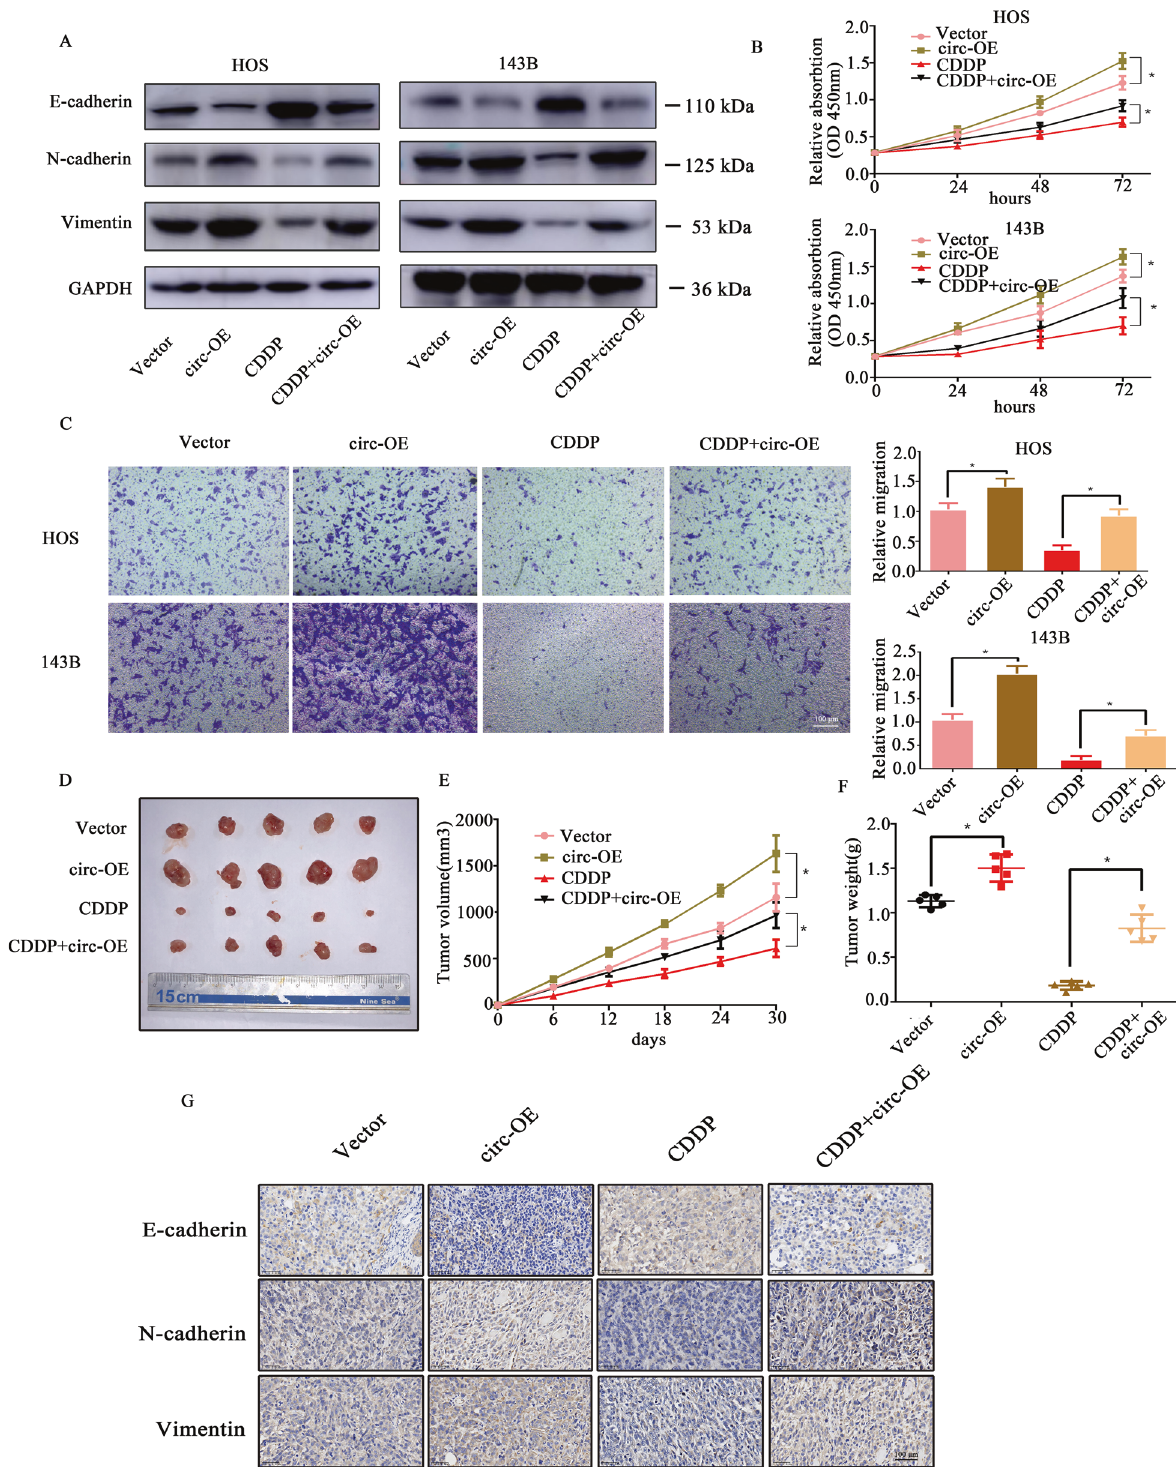
Fig. 7 Overexpression of circPRKAR1B suppresses the sensitivity of OS cells to CDDP. A Protein levels of molecules related to EMT in OS cells treated as indicated. B CCK8 assay was used to analyse the growth capacity of OS cells treated as indicated. C The migration ability of HOS and 143B cells treated as indicated. D Images of a tumour xenograft model ( n = 5). E Statistical analysis of tumour volume among the four indicated groups on the indicated days. F Statistical analysis of tumour weight among the four indicated groups. G Immunohistochemical analyses of xenograft tumours. IHC staining was performed using antibodies against E-cadherin, N-cadherin and Vimentin. The error bars represent the SD of three independent experiments (* P < 0.05).